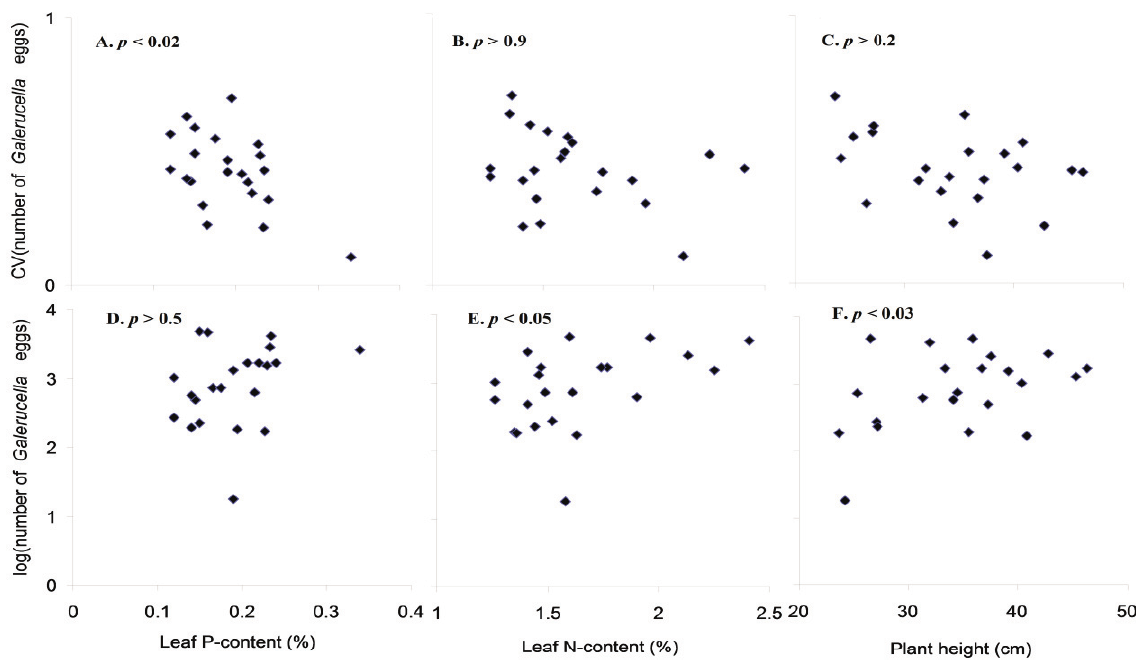
Figure 4. Relationships between L. salicaria leaf P-content ( A , D ); N-content ( B , E ); plant height ( C , F ) and mean number of Galerucella per plant ( D – F ) and the coefficient of variation (CV) of the number of Galerucella over four years (a – c).